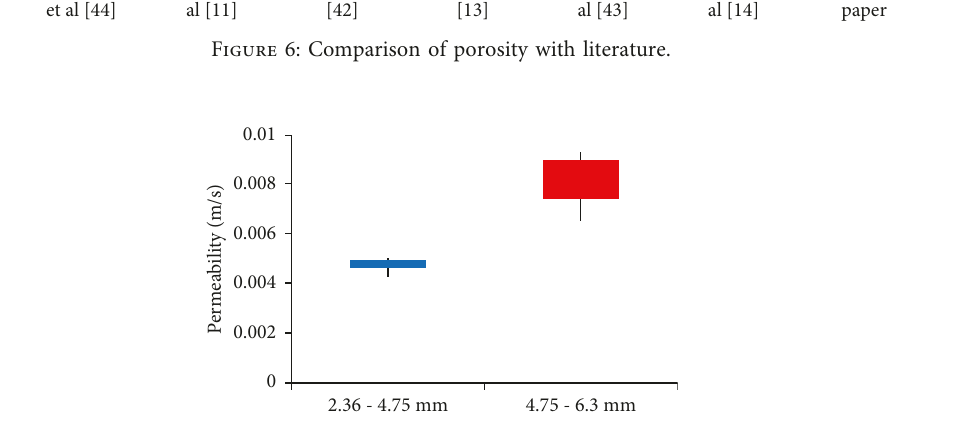
Figure 7: Box plot of variations of permeability for both aggregate size gradations.